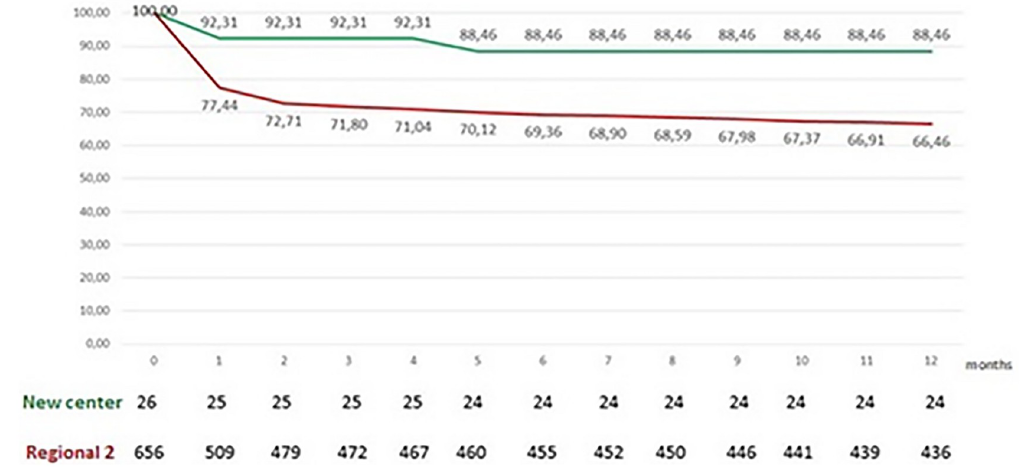
Fig 2. Survival of patients operated on at the new center during the first year of the partnership (plotted in green), compared to that of patients operated on at other transplant centers outside of the S ã o Paulo state capital (Regional 2, plotted in red).